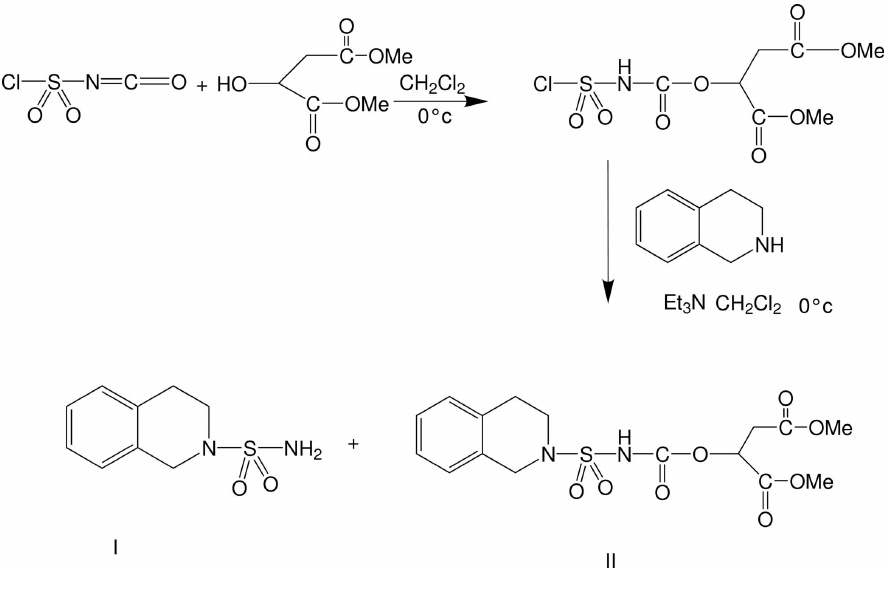
Figure 2 Partial packing view showing the formation of the two dimensional network. H bonds are represented as dashed lines. H atoms not involved in hydrogen bonding have been omitted for clarity. [Symmetry codes: (i) x - 1, y , z ; (ii) - x + 1, y + 1/2, - z +